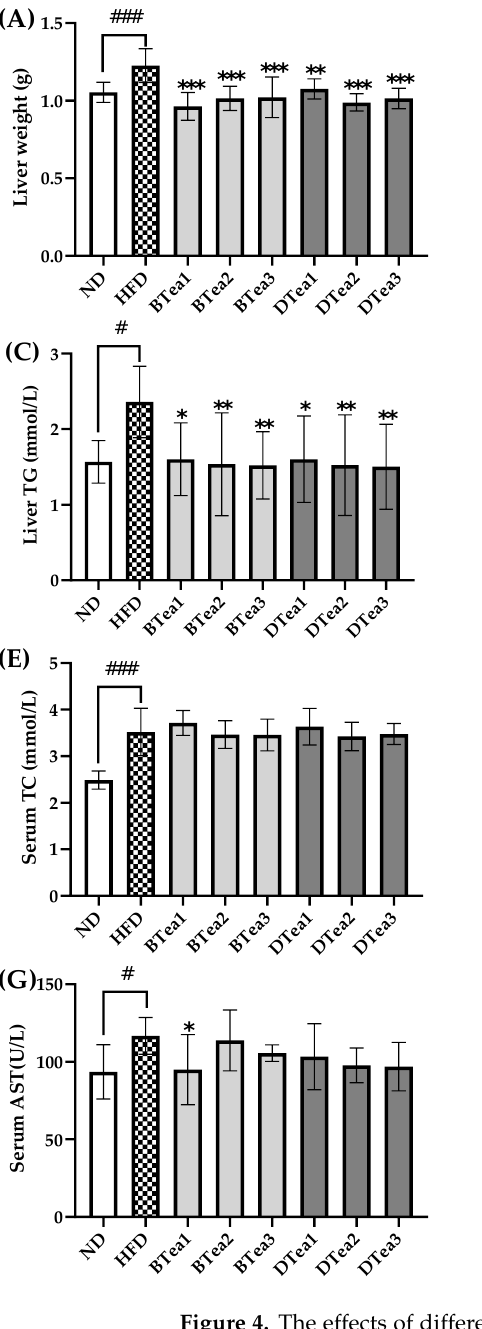
Figure 4. The effects of different black and dark teas on the features related to NAFLD. ( A ) Liver weight; ( B ) liver coefficient; ( C ) liver triacylglycerol level (Liver TG); ( D ) serum triacylglycerol level (Serum TG); ( E ) serum total cholesterol level (Serum TC); ( F ) serum low-density lipoprotein cholesterol level (Serum LDL-C); ( G ) serum aspartate transaminase (Serum AST); ( H ) serum alanine aminotransferase (Serum ALT). The results are expressed as mean ± standard deviation. ND, the control group (normal diet group); HFD, the model group (high-fat diet group); BTea1, selenium-enriched black tea; BTea2, Dianhong tea; BTea3, Yingde black tea; DTea1, Fu brick tea; DTea2, Liupao tea; DTea3, selenium-enriched dark tea. # p < 0.05, ### p < 0.001, the HFD group compared with the ND group; * p < 0.05, ** p < 0.01, *** p < 0.001, the tea extract supplementary groups compared with the HFD group. ns, no statistically significant differences ( p > 0.05) between the model group and the control